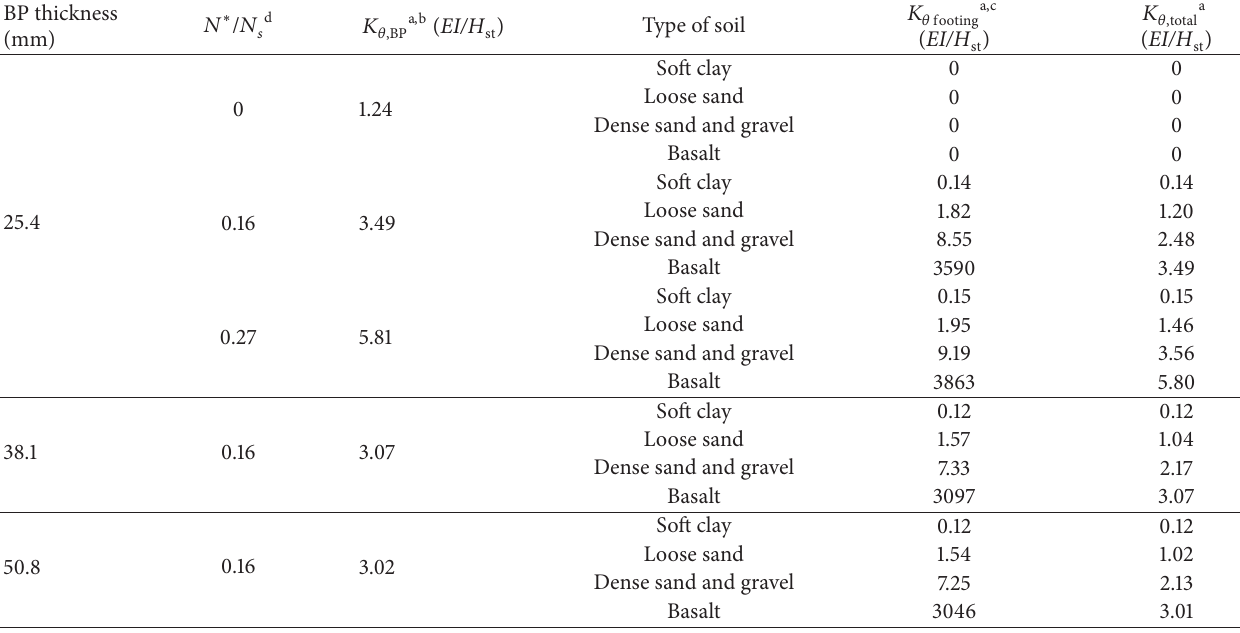
Table 1: Test data of baseplate from Gomez [17] tests and evaluation of 𝐾 𝜃 for different types of soil based on Melchers [16]. BP